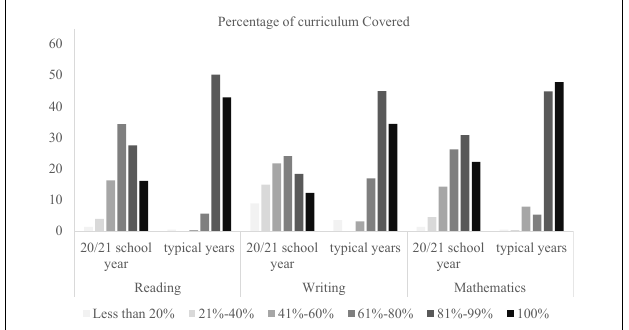
FIGURE 3 | Percentage of students ready to transition to next